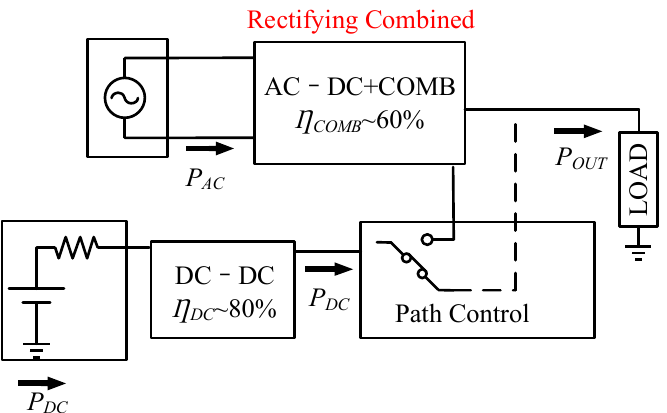
Figure 17. Improved mixed AC and DC harvesting system.